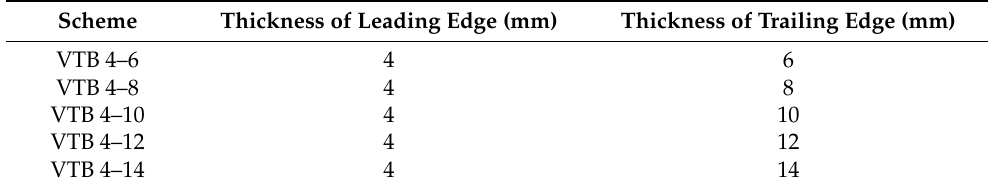
Table 5. VTB impeller design scheme.